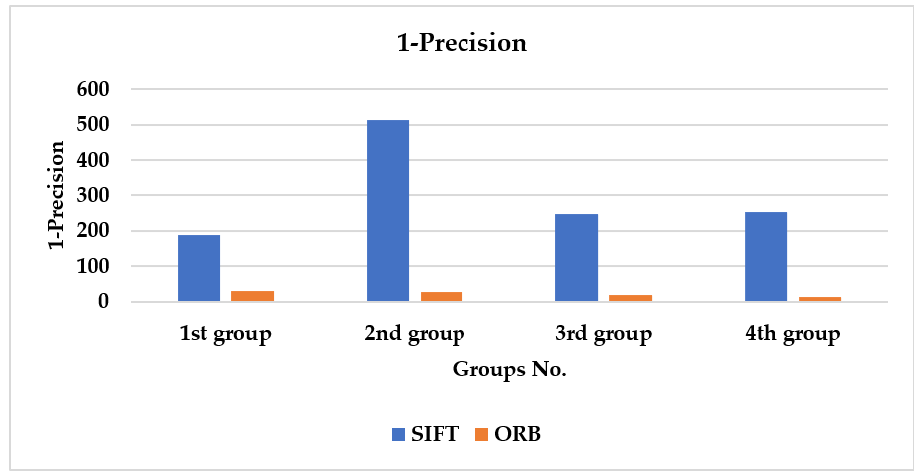
Figure 14. Average computed 1-precision over the four groups created from ImageNet-Sketch dataset based on handcrafted